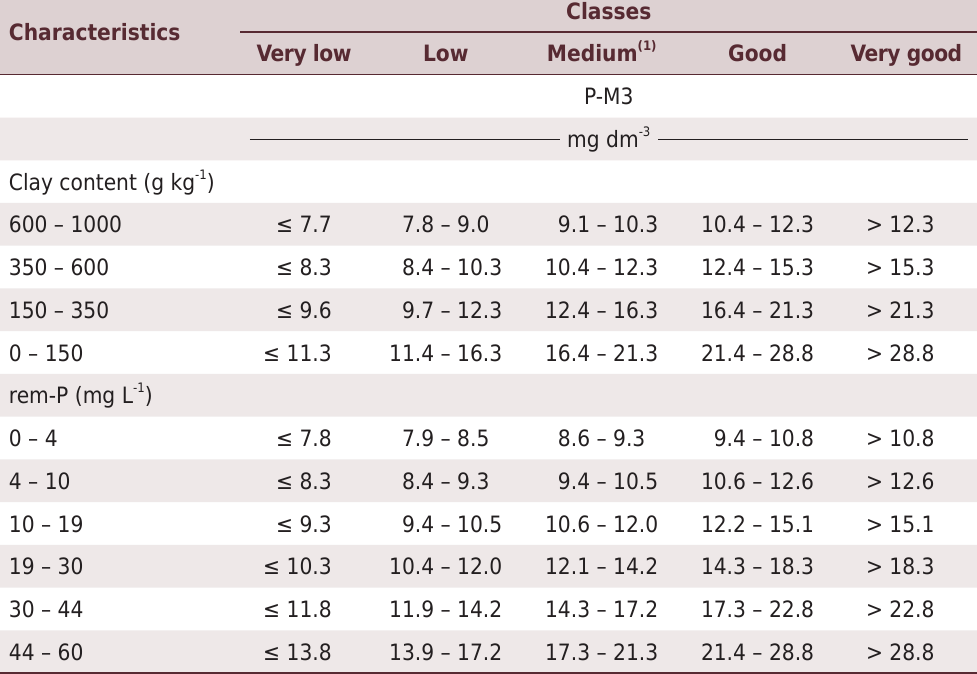
Table 7. Classes for soil P availability interpretation by Mehlich-3 extractant (P-M3), according to the proportion of clay content or